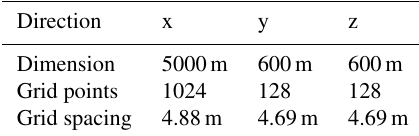
Table 1. Key characteristics of domain and grid of simulated wind field.